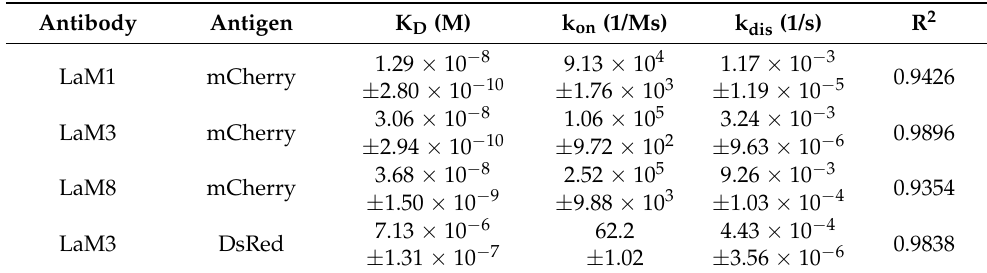
Table 2. The binding kinetics and affinity parameters of LaM1, LaM3, and LaM8 nanobodies to mCherry or DsRed by bio-layer interferometry.